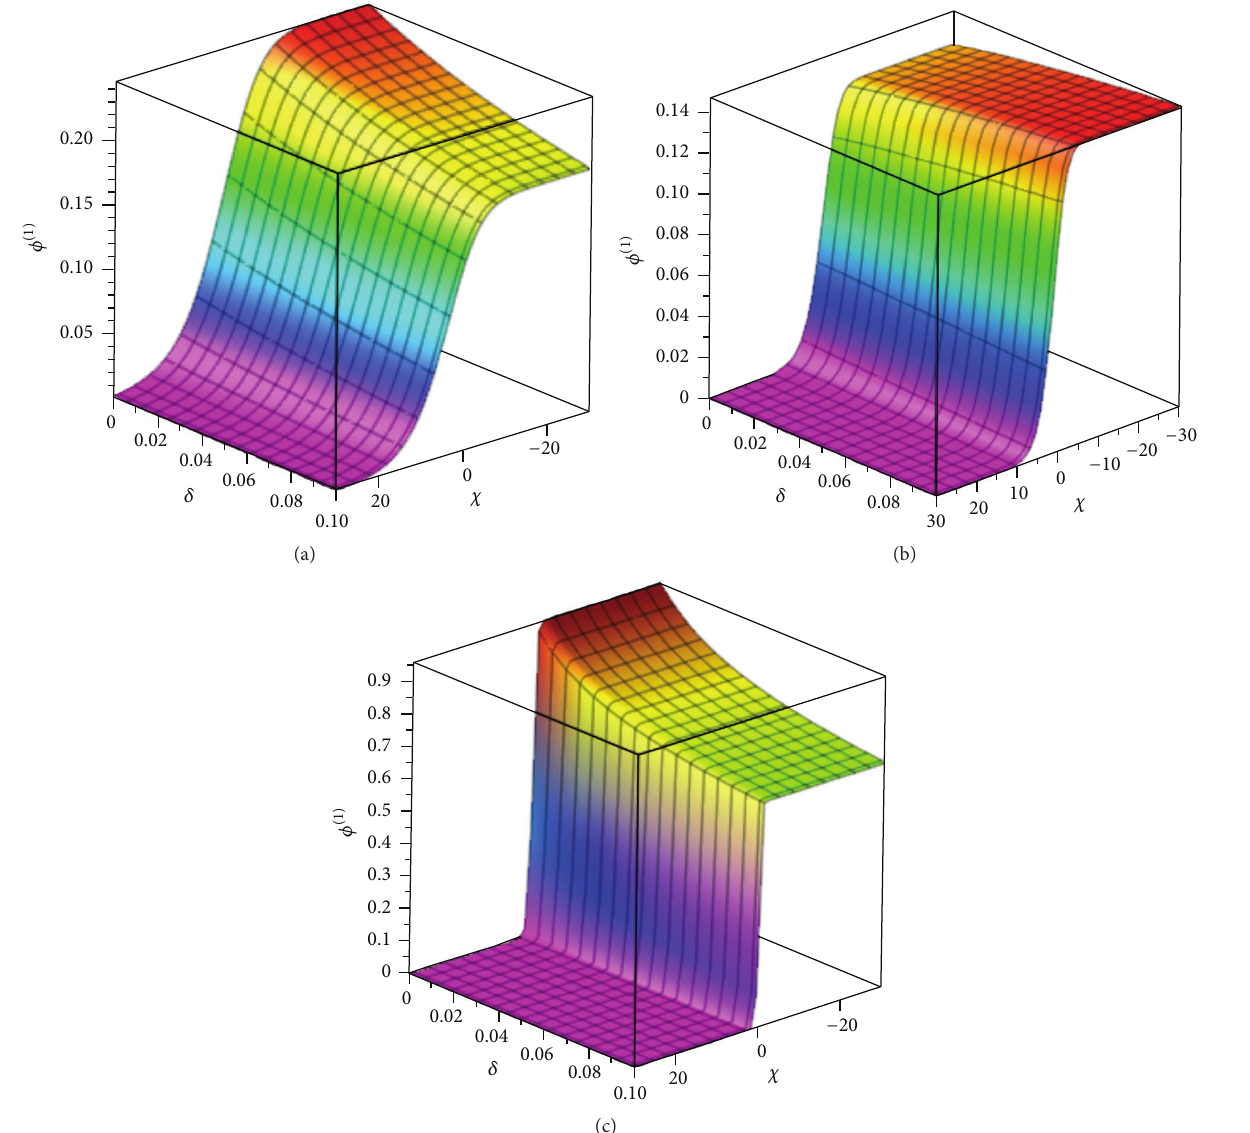
Figure 3: Variation of potential of electrostatic shock waves with respect to 𝜒 and 𝛿 taking the fixed values of (a) 𝑞 = 0.6 (superthermality), = 0.9 , 𝜎 = 1 (low), and 𝜇 = 0.95 . (b) The same values of (a) but 𝜎 = 10 (high). (c) 𝑞 = 4 (subthermality), 𝛼 = 0.1 , 𝛼 = 0.1 , 𝛽 = 0.1 , 𝑢 𝑖0 0 = 0.95 𝛽 = 0.1 , 𝜎 = 10 , and 𝜇 0